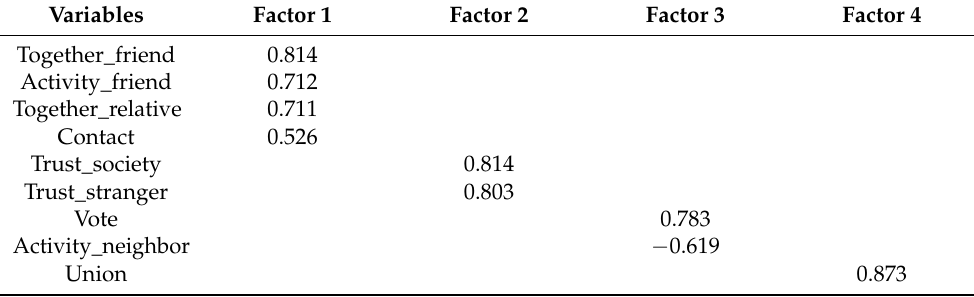
Table A2. Rotated Factor Matrix